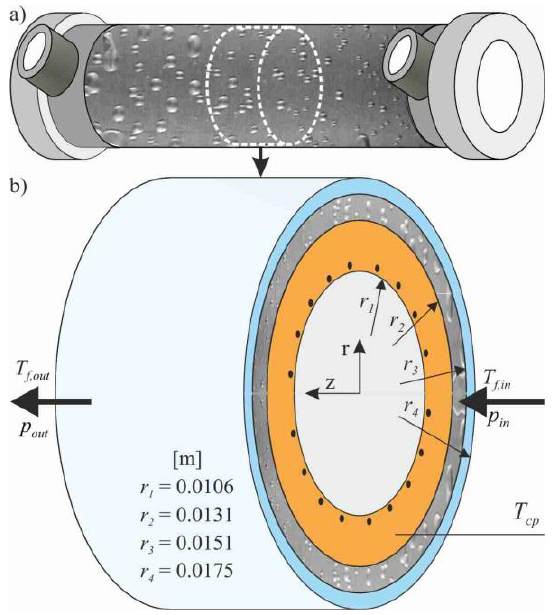
Figure 3. The schemes of the test section: ( a ) a general view and ( b ) a cross-section with marked layers used in the mathematical model.